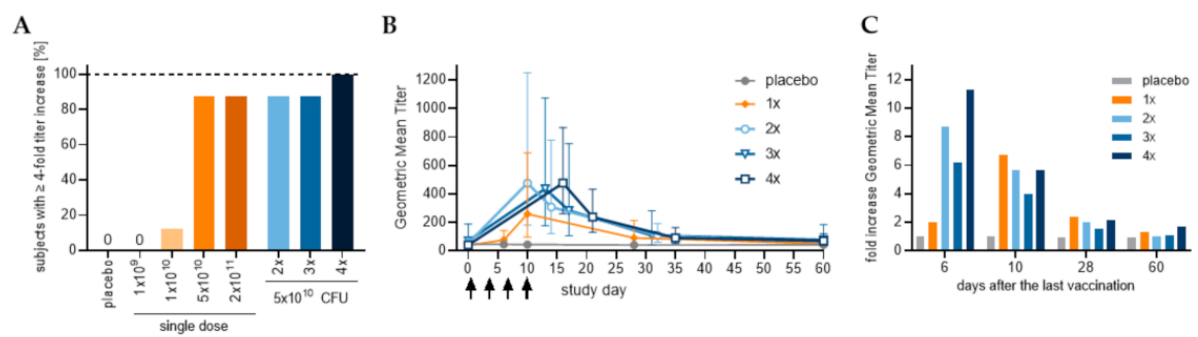
Figure 4. Serum anti-ShigETEC lysate responses. ( A ) Subjects responding with at least 4-fold increase in anti-ShigETEC IgA titer at any sampling day compared to pre-immune titer in serum. ( B ) Geometric mean titers and % CV of serum anti-ShigETEC IgA are given for all cohorts which received 5 × 10 10 CFU/dose ShigETEC or placebo. ( C ) Fold increase of geometric mean titers for all cohorts which received 5 × 10 10 CFU/dose ShigETEC or